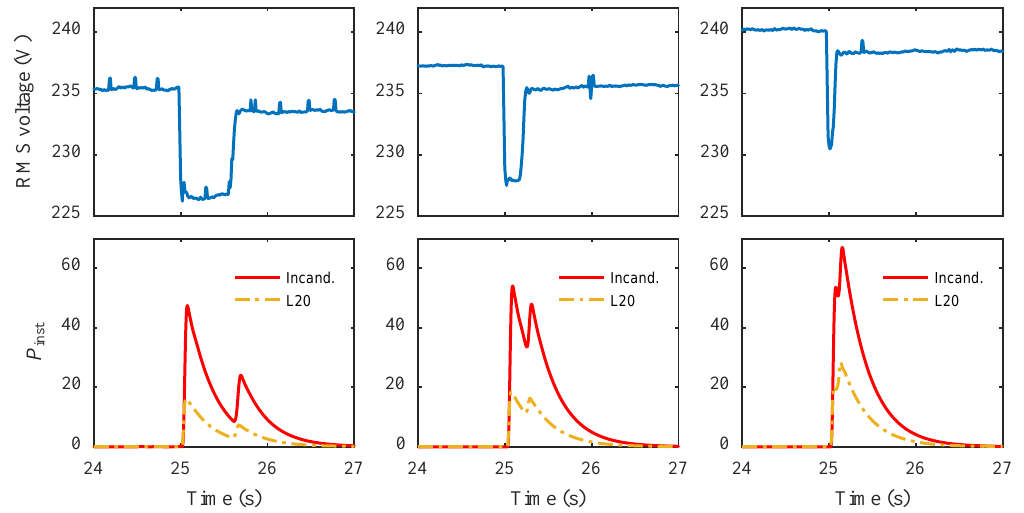
Figure 10. Comparison of the response of the L20 lamp with the incandescent lamp, when subjected to an RVC made of two consecutive instantaneous ramps with different separations. RMS voltage (top graphs) and instantaneous flicker perception (bottom